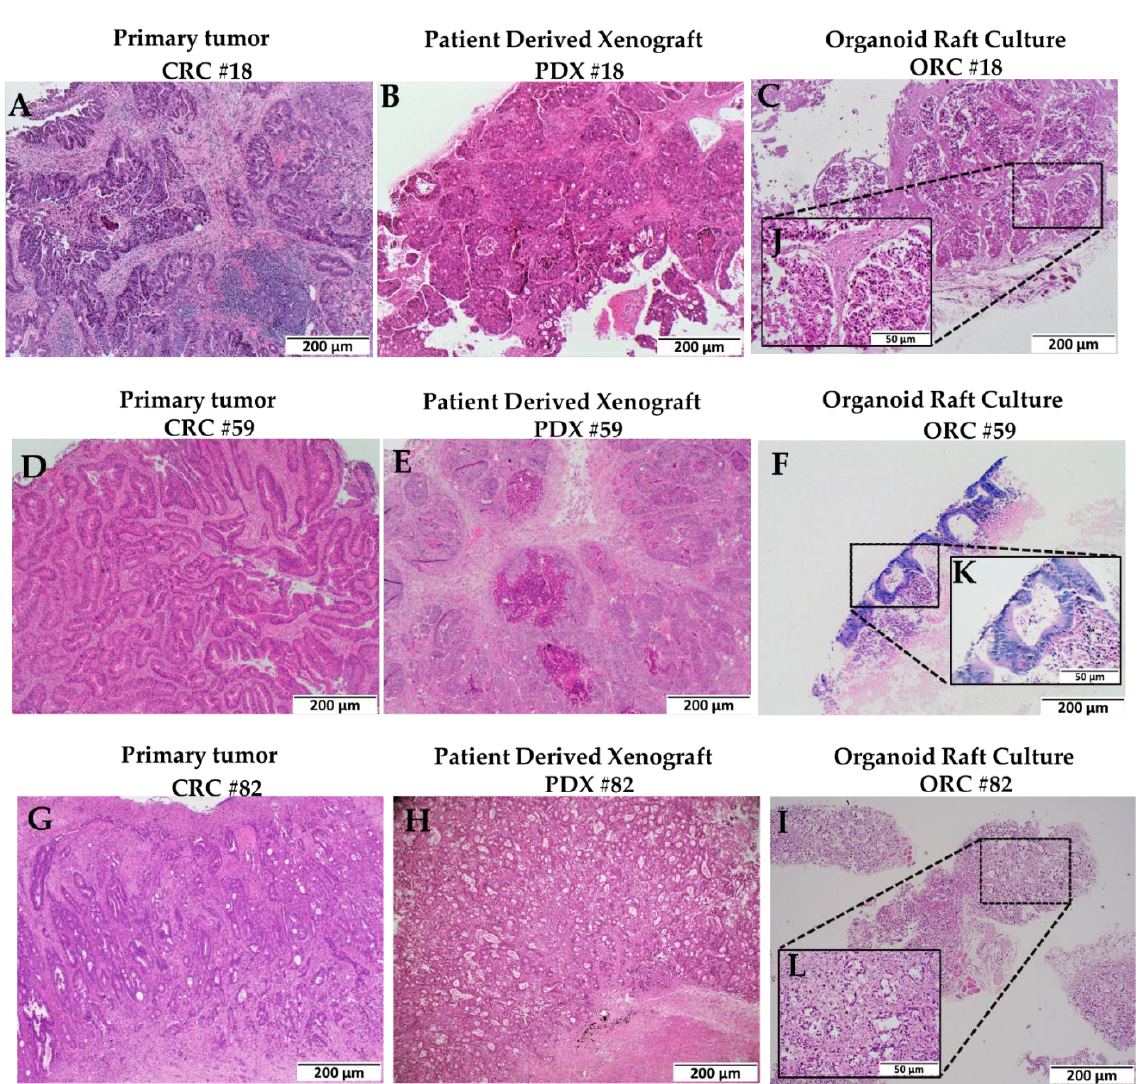
Figure 2. Morphological features were well retained from primary tumor to patient-derived xeno- grafts (PDXs) to organoid raft cultures (ORCs) . Hematoxylin and eosin (H&E) images at 4× magnification (scale bar: 200 µm) in ( A – I ) and panels ( J – L ), which are shown in the insets with dotted lines and captured at 20× magnification to showcase glandular morphology of colorectal cancers (CRCs) (scale bar: 50 µm). Panels ( A , D , G ) are primary tumors (CRCs); panels ( B , E , H ) are PDXs; and panels ( C , F , I ) are ORCs derived from three different CRC patients.